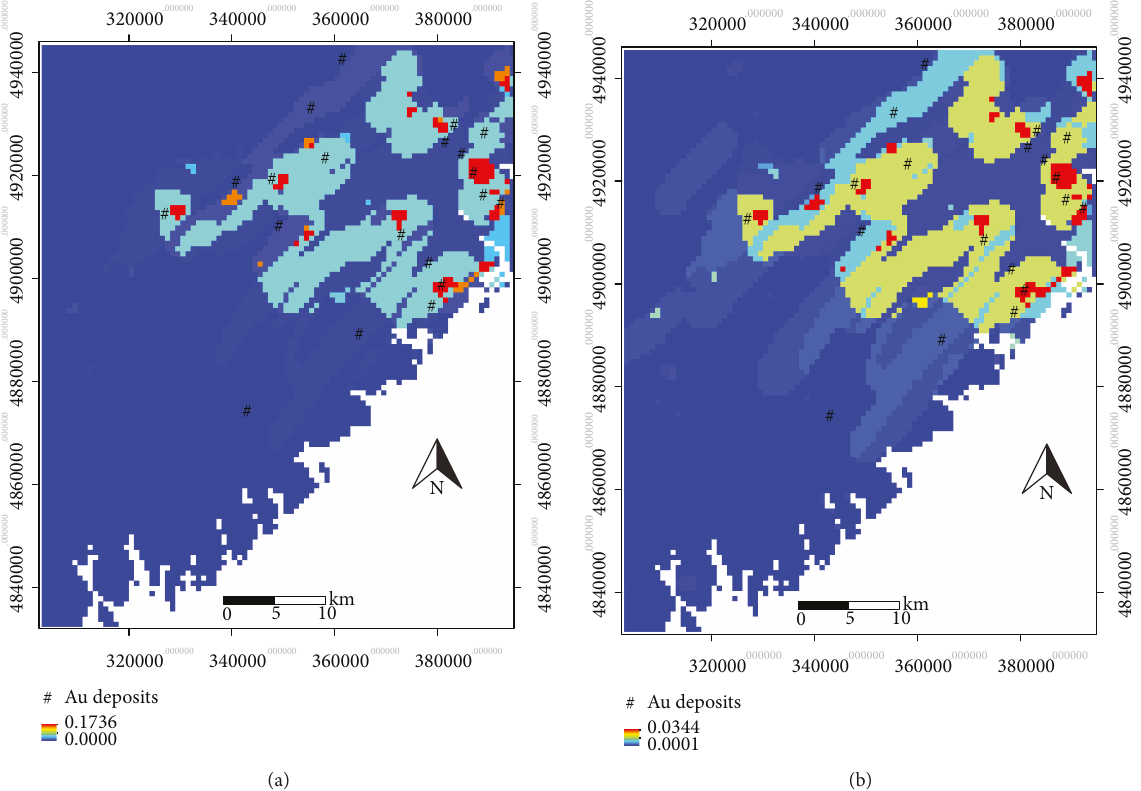
Figure 2: Posterior probability maps obtained by (a) weights of evidence and (b) logistic regression in experiment